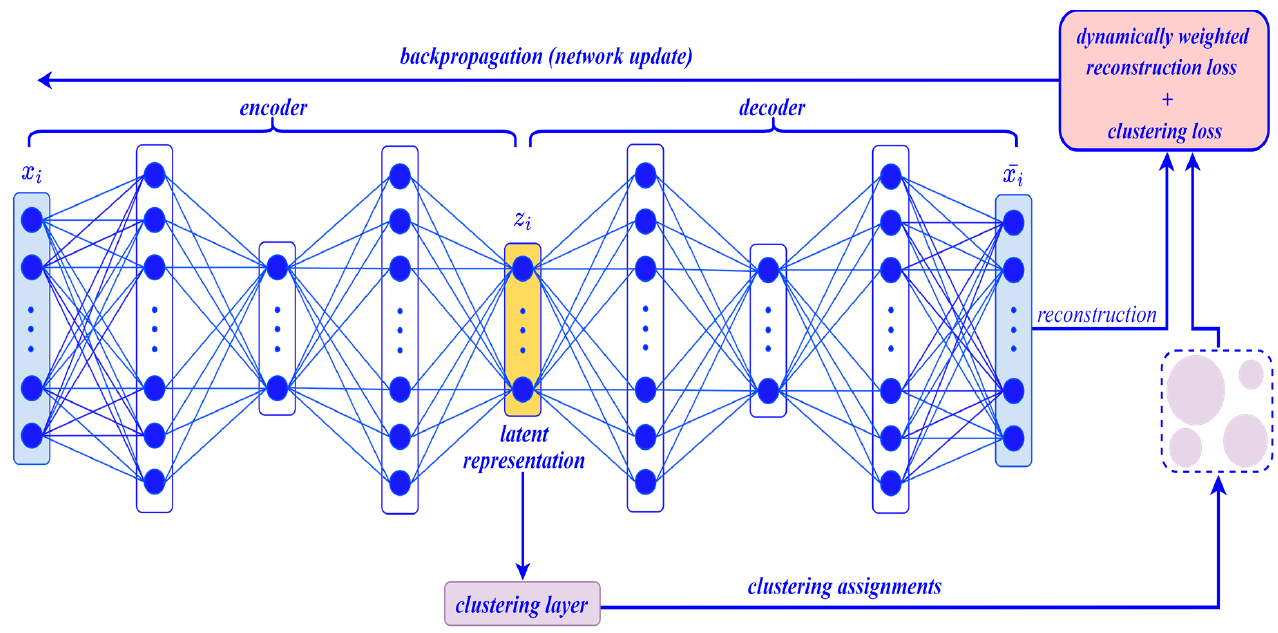
Figure 3. The proposed deep clustering method. Algorithm 1: The Proposed Deep Clustering Method